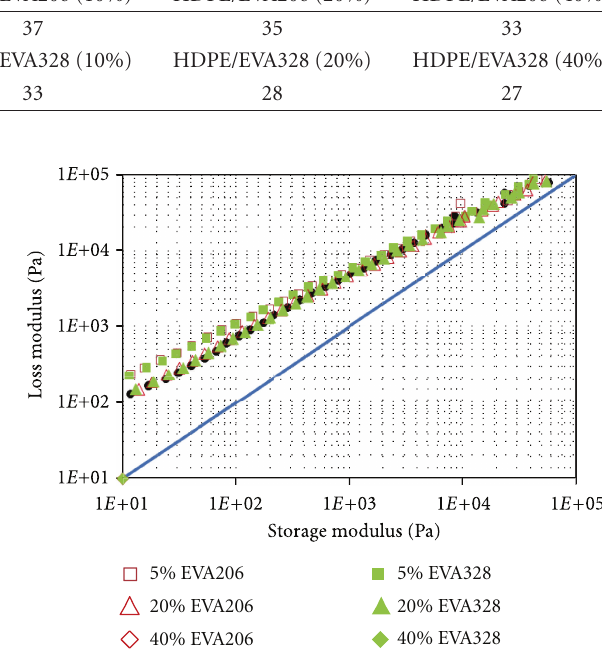
Figure 7: Cole-Cole diagram of HDPE/EVA